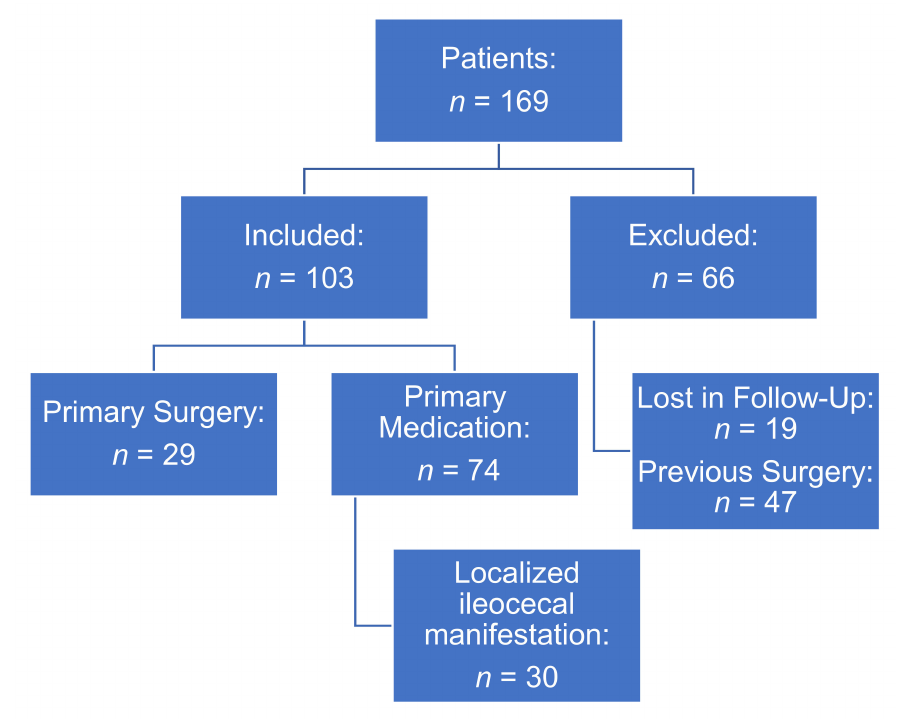
Figure 1. Study design. Table 1. Patient demographics and clinical